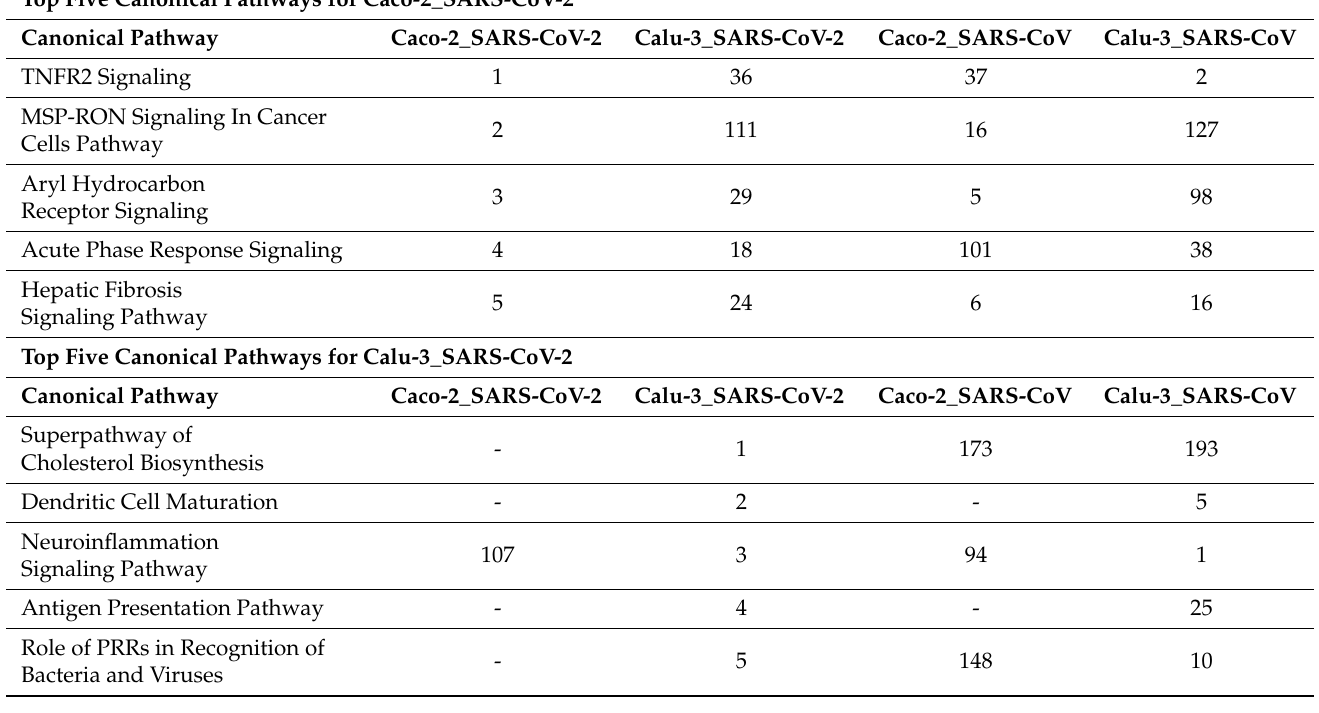
Table 1. The top five Canonical Pathways and the overlap among the conditions. The top five Canoni- cal Pathways for the conditions “Caco-2_SARS-CoV-2”, “Calu-3_SARS-CoV-2”, “Caco-2_SARS-CoV”, and “Calu-3_SARS-CoV-2” are given. For each condition, the top five Canonical Pathways are compared with those in the remaining three conditions; the position in the corresponding list for the indicated condition is given. Only statistically significant Canonical Pathways are included in the